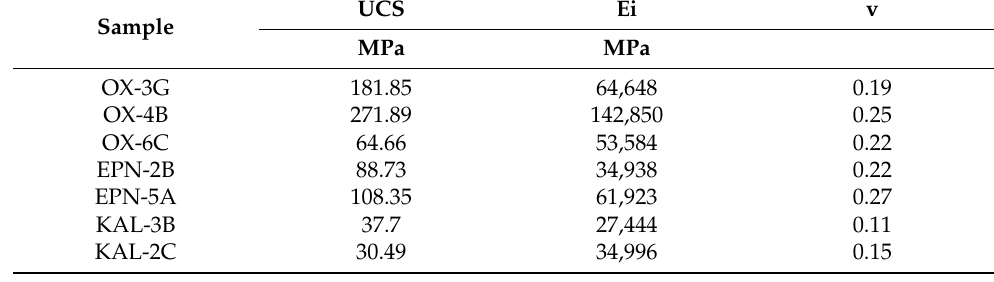
Table 6. UCS, Ei, and v values derived from mechanical tests at the University of Leeds (Rock Mechanics, Engineering Geology and Geotechnical (RMEGG) Laboratories).